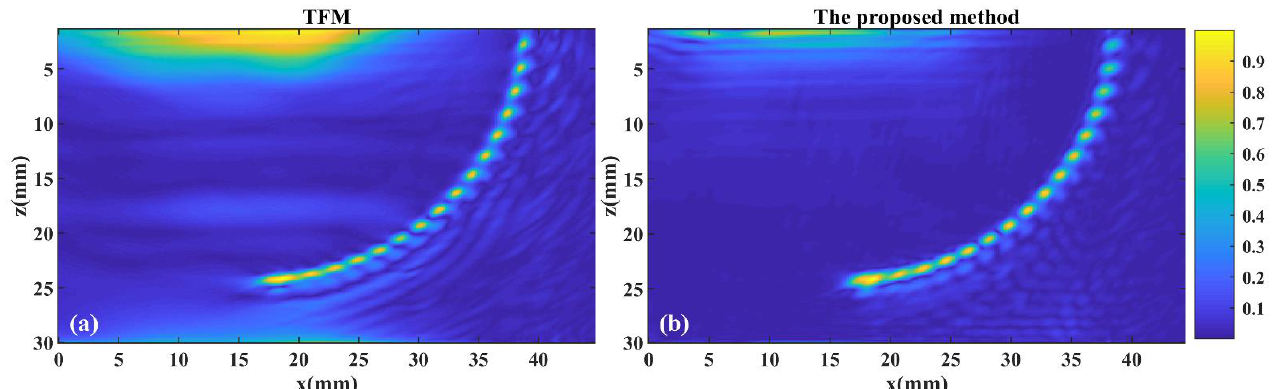
array ultrasonic testing. ( b ) The tilted wedge.